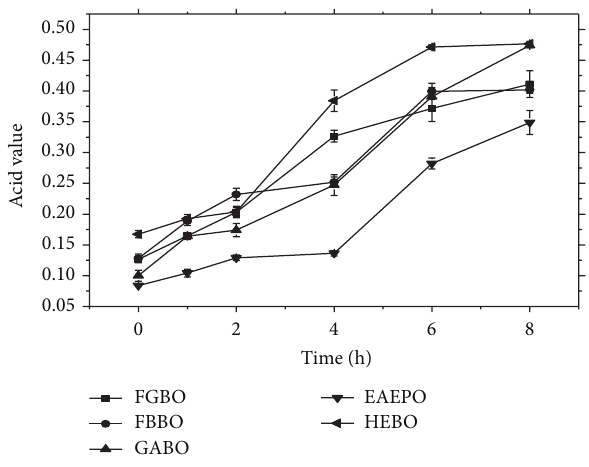
Figure 1: Changes in acid